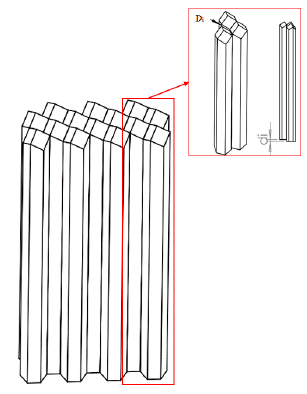
ff erence between the neighboring pins in a double-pin Figure 13. The height difference between the neighboring pins in a double-pin group. Figure 13. The height di